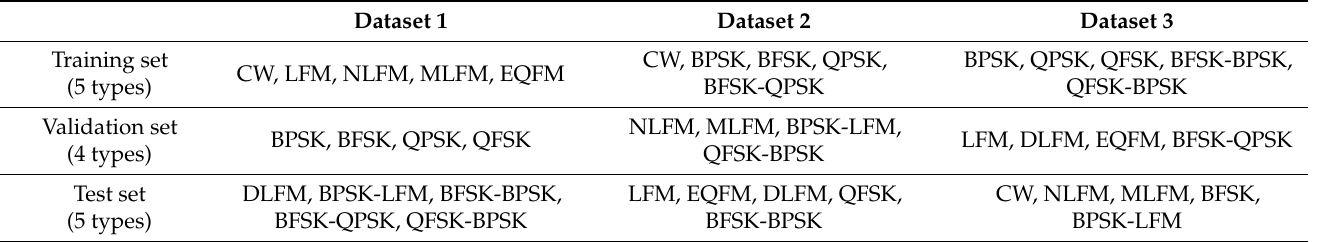
Table 2. Different classifications of